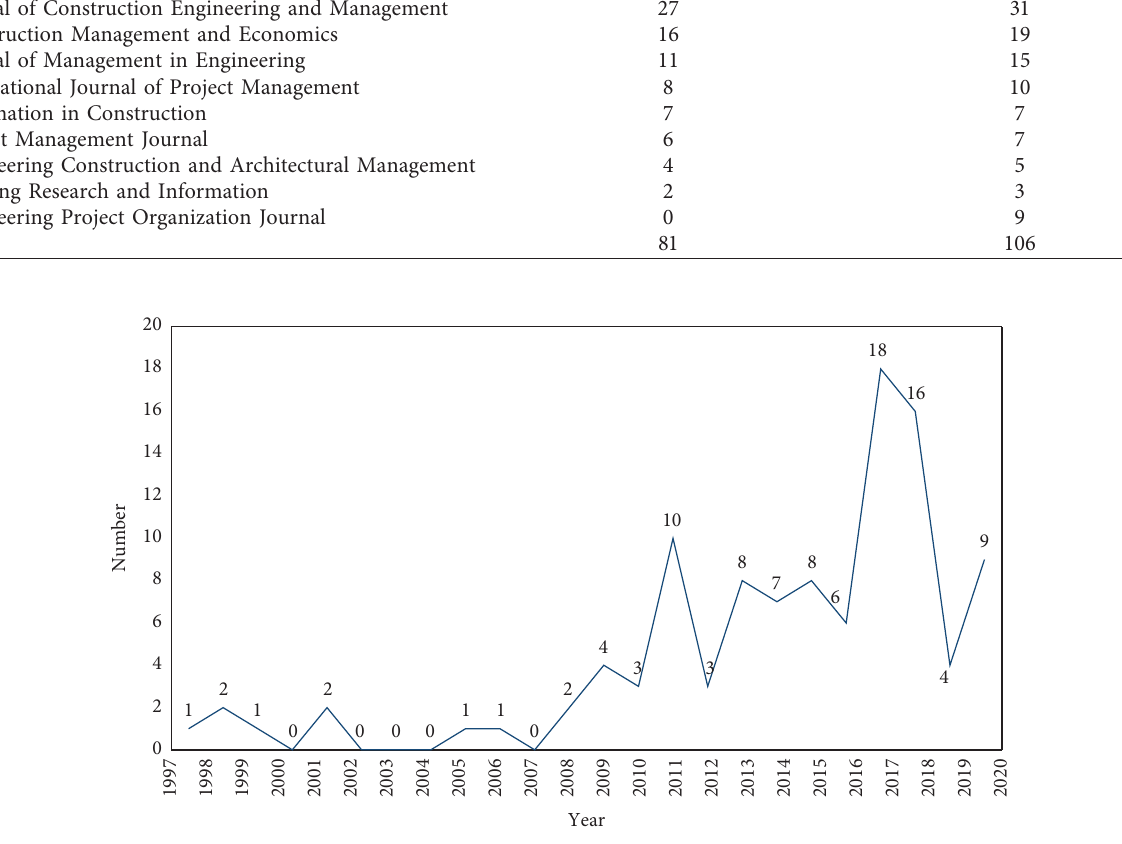
Figure 2: Number of identified publications from 1997 to 2020.